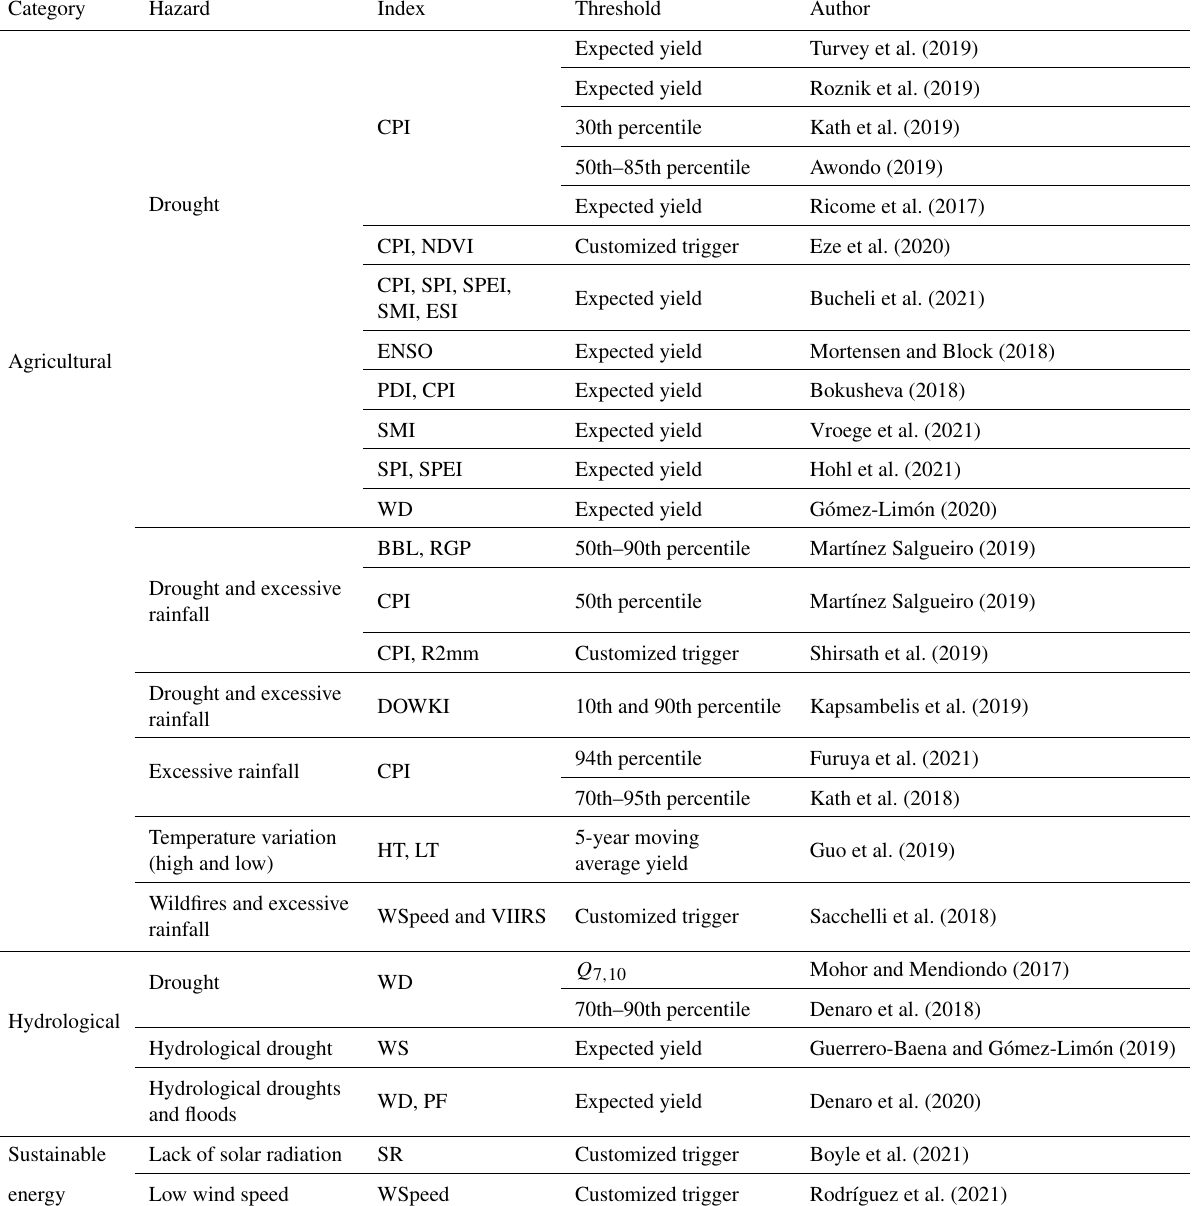
Table 2. Main categories for index-based insurance and their specific application. Indices: cumulative precipitation index (CPI), water storage (WS), water deficit (WD), normalized difference vegetation index (NDVI), soil moisture index (SMI), standardized precipitation evapotranspiration index (SPEI), standardized precipitation index (SPI), El Niño–Southern Oscillation (ENSO), evaporative stress index (ESI), Ped’s drought index (PDI), Ribéreau–Gayon and Peynaud hydrothermal scale (RGP), sum of 2 consecutive days’ rainfall exceeding a given threshold value (R2mm), Drought and Overwhelmed Water Key Indicator (DOWKI), Berman and Levadoux (BBL), high temperature (HT), low temperature (LT), peak flow (PF), Visible Infrared Imaging Radiometer Suite (VIIRS), solar radiation (SR), and wind speed